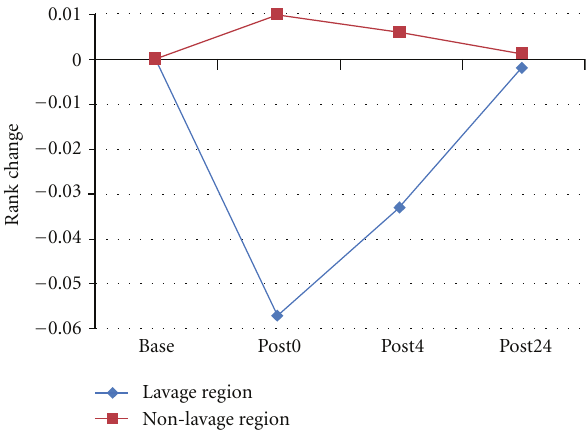
Figure 13: Observance of regional function change over time by tracking the rank change of Jacobian estimates over four phases within lavage region and non-lavage